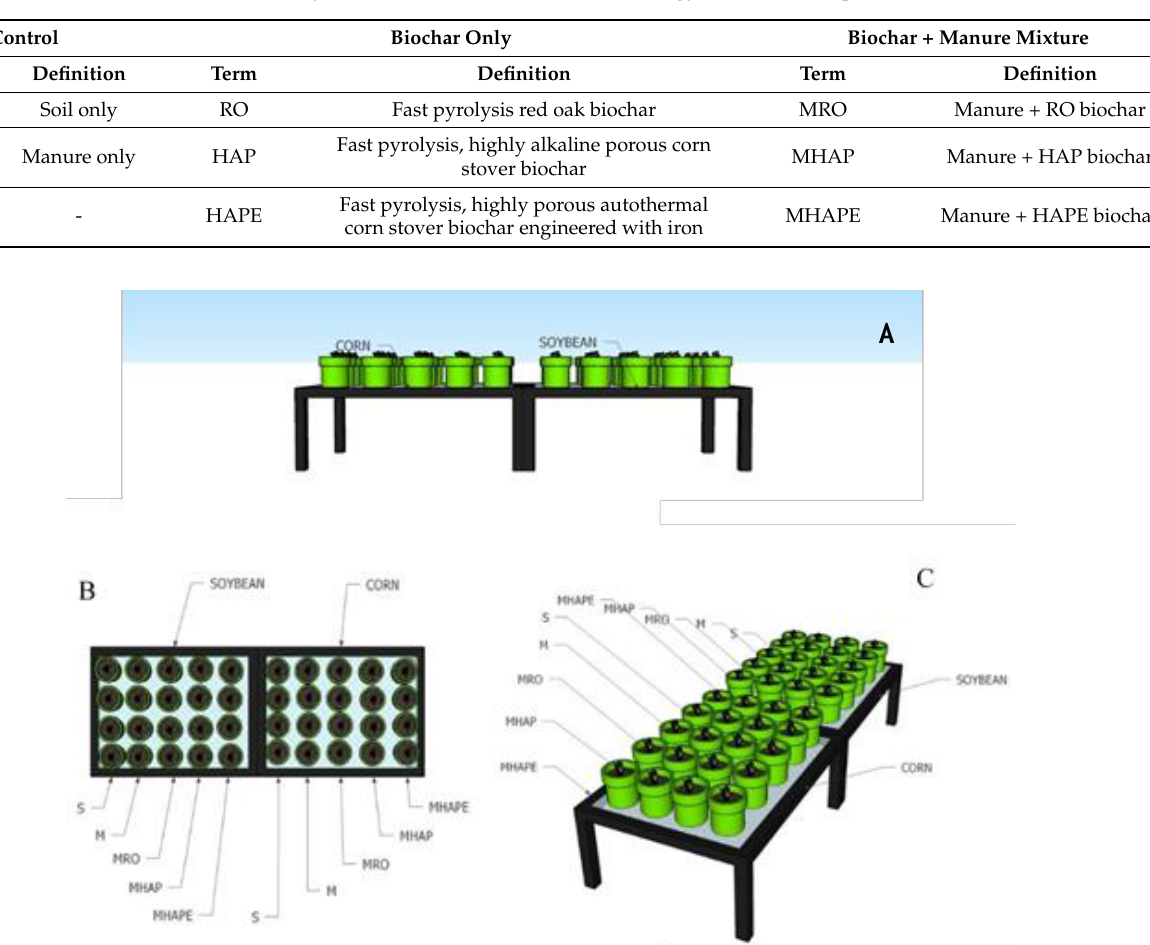
Table 1. Summary of control and treatment terminology used in the experiment.